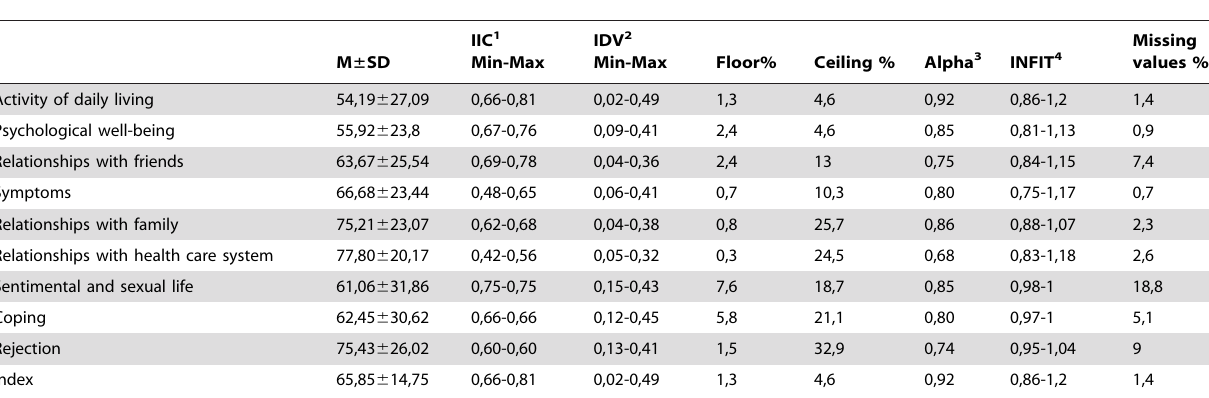
Table 1. Internal structural validity/reliability/unidimensionality of the reference population*.